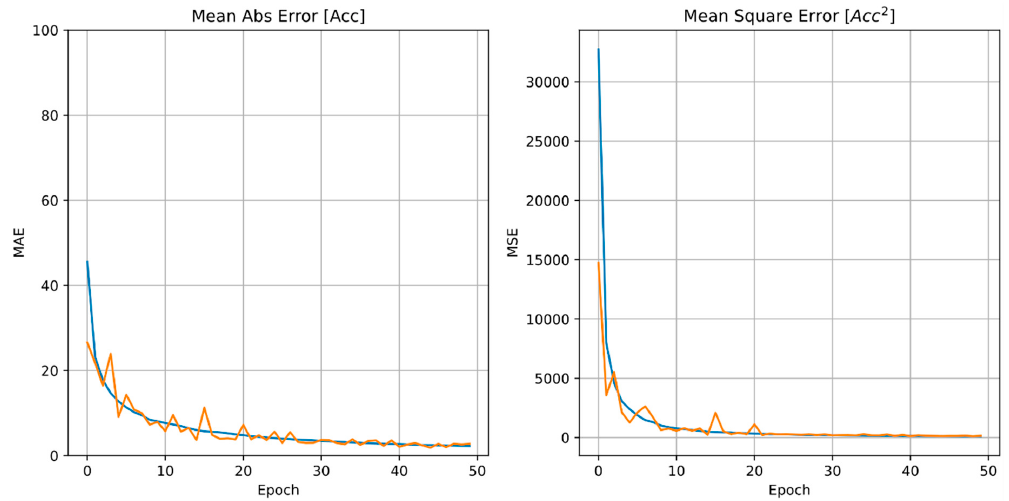
Figure 6. ANN MAE in predicting the acceleration variable ‘ Acc ’ased on epoch number. Orange line: actual values; blue-line: averaged values.